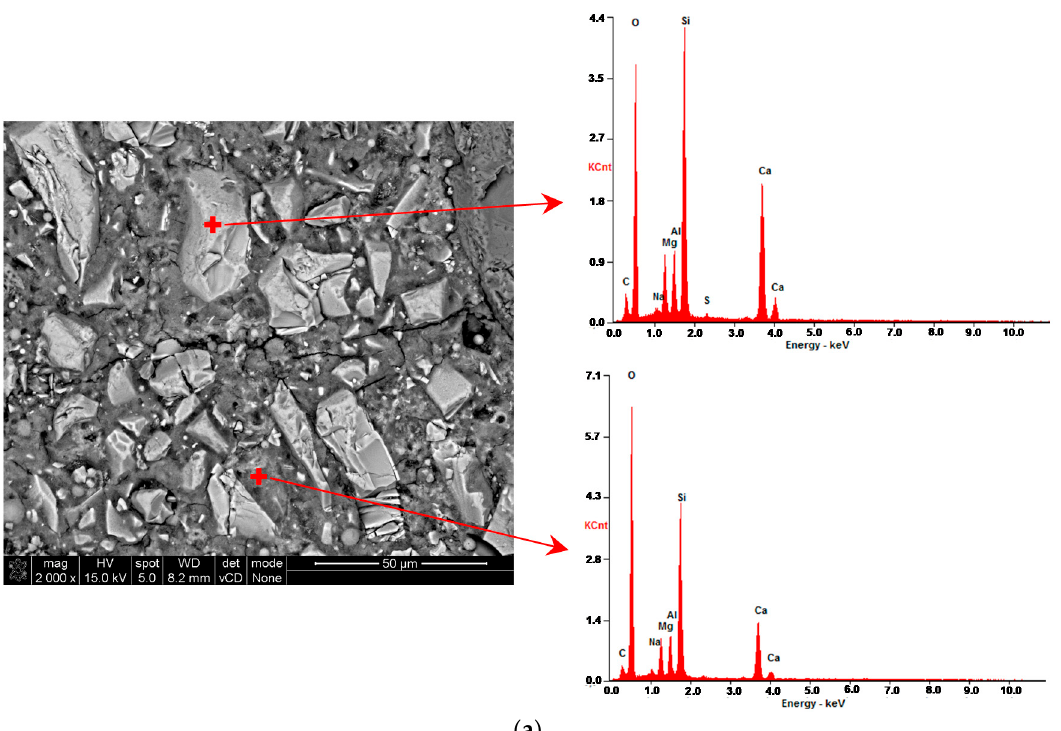
Figure 7. SEM images (BSE) presenting the microstructures of the ( a , b ) C55_SFA15_SF3, ( c , d ) C100_SFA15_SF3, and ( e , f ) C100_SFA30_SF3 samples.